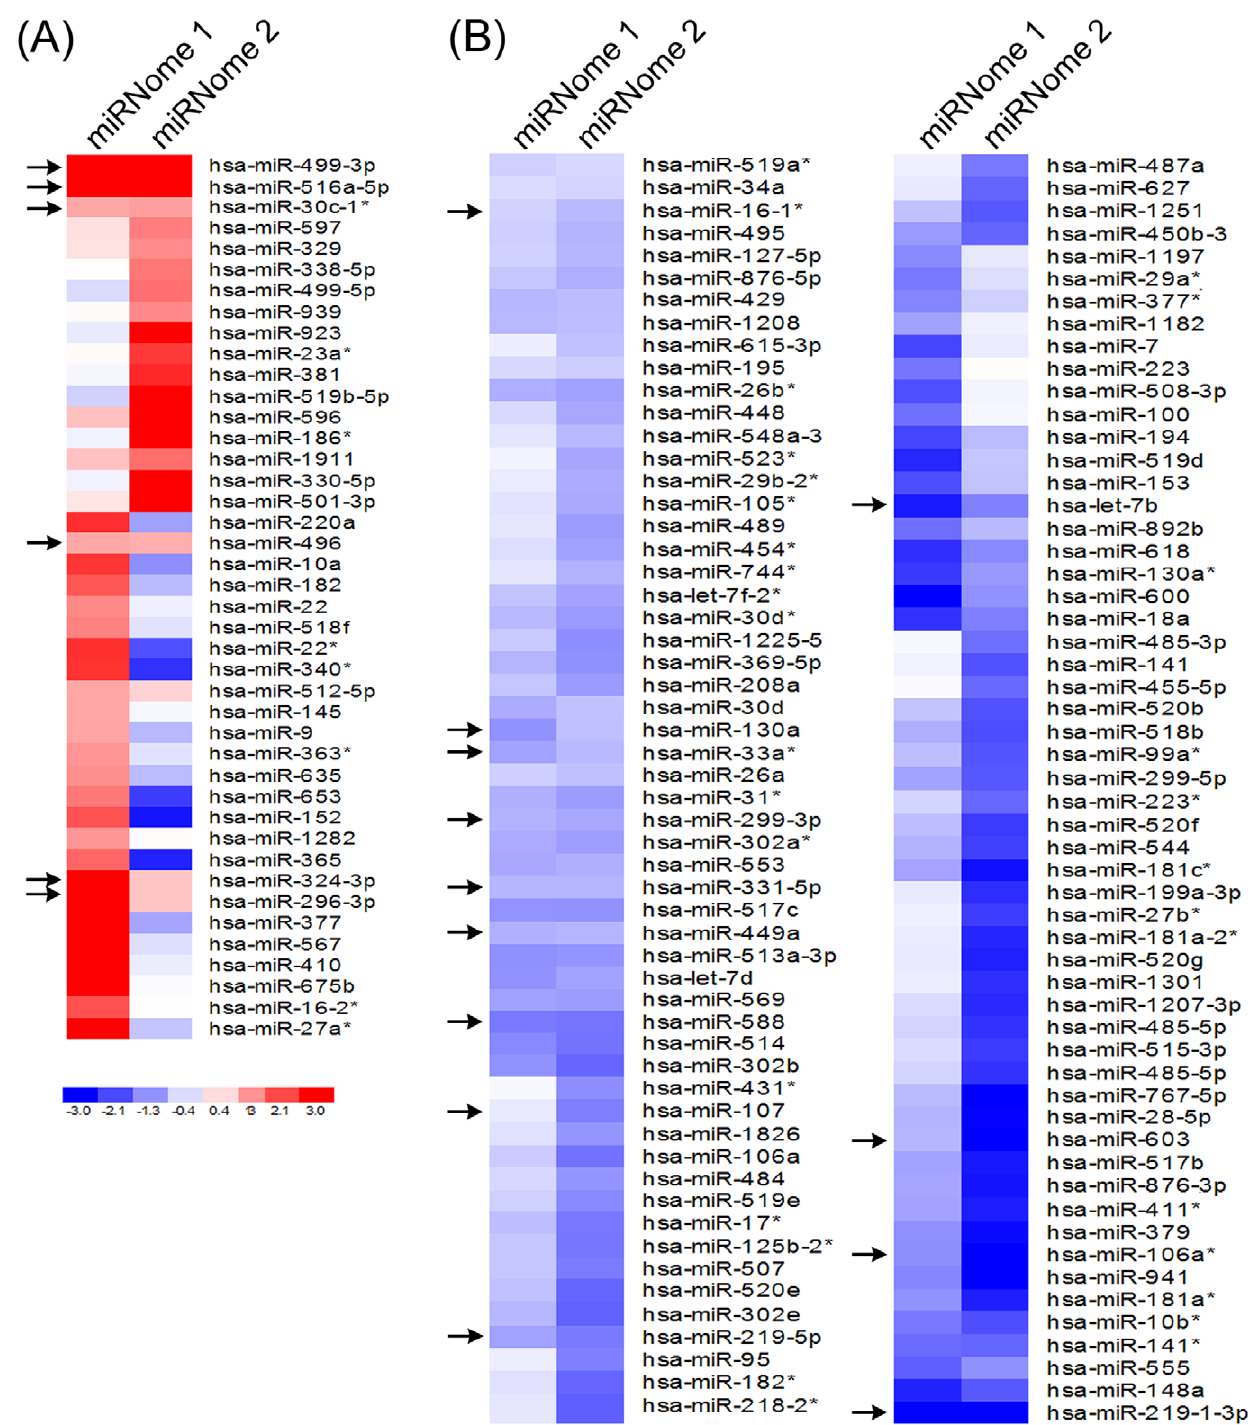
Figure 1. Downregulation of miRNA expression in old individuals. For each panel, one young 30- year-old participant and one old 64-year- old participant were screened for miRNA expression using a real-time RT-PCR based miRNome miRNA profiler kit as described in Materials and Methods. Different pairs of individuals were used for both miRNome 1 and miRNome 2. The heat map was generated using dChip software and indicates the fold log 10 relative change in expression in young versus old participants[49]. The top upregulated and downregulated miRNAs are shown. Blue indicates downregulation of miRNA expression in the old individuals and red indicates upregulation of miRNA expression in the old individuals. Each patient was sex and race matched as indicated in Table 1. A detailed spreadsheet of the data is available as supplementary information (Table S1). * next to the microRNA refers to the minor form of the miRNA.